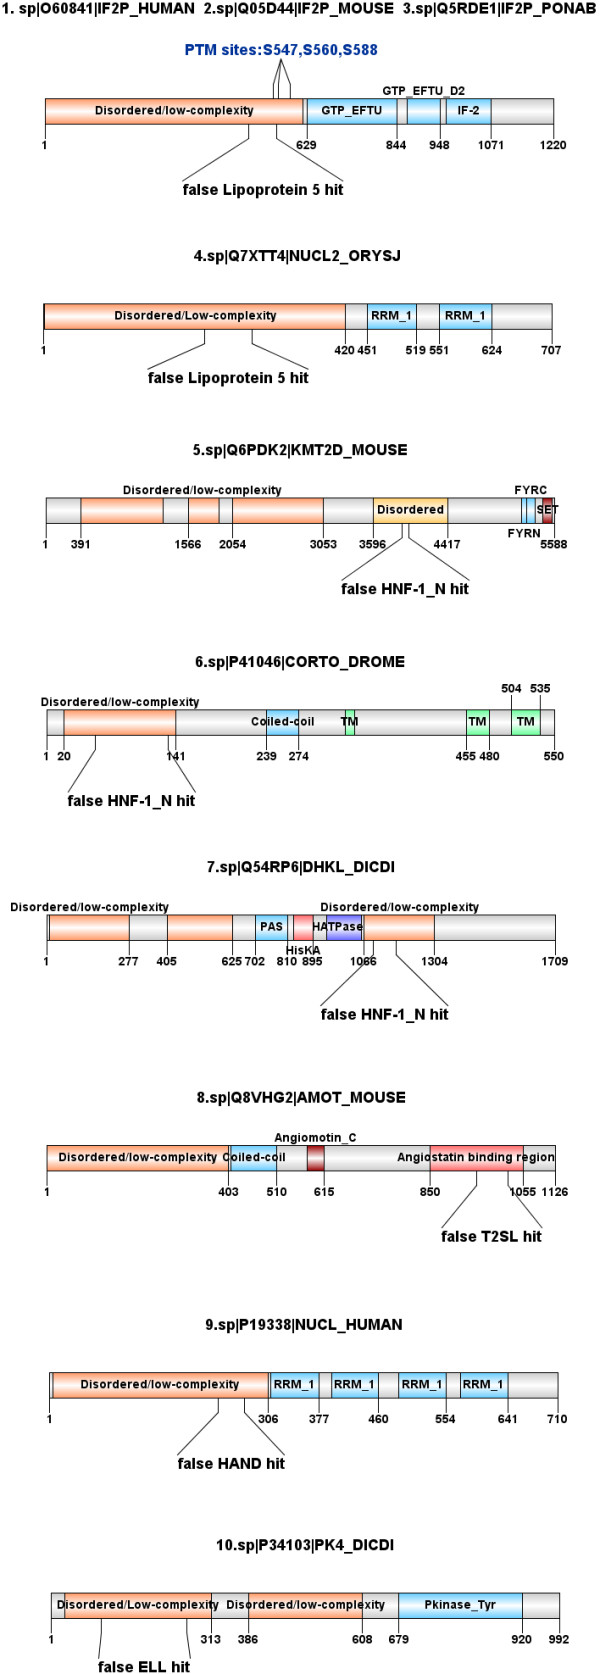
Domain architectures of the 10 false (false-positive) hits. The domain architectures of 5 Pfam domain models (PF01298.13 Lipoprotein5, PF05134.8 T2SL, PF09110.6 HAND, PF10390.4 ELL) revealed that the 10 hits (1:IF2P_HUMAN, 2:IF2P_MOUSE, 3:IF2P_PONAS, 4:NUCL2_ORYSJ, 5:KMT2D_MOUSE, 6:CORTO_DROME, 7:DHKL_DICDI, 8:AMOT_MOUSE, 9:NUCL_HUMAN, 10:PK4_DICDI) are falsely associated to the respective domain models through a significant non-structural segment which is typically low-complexity and disordered.